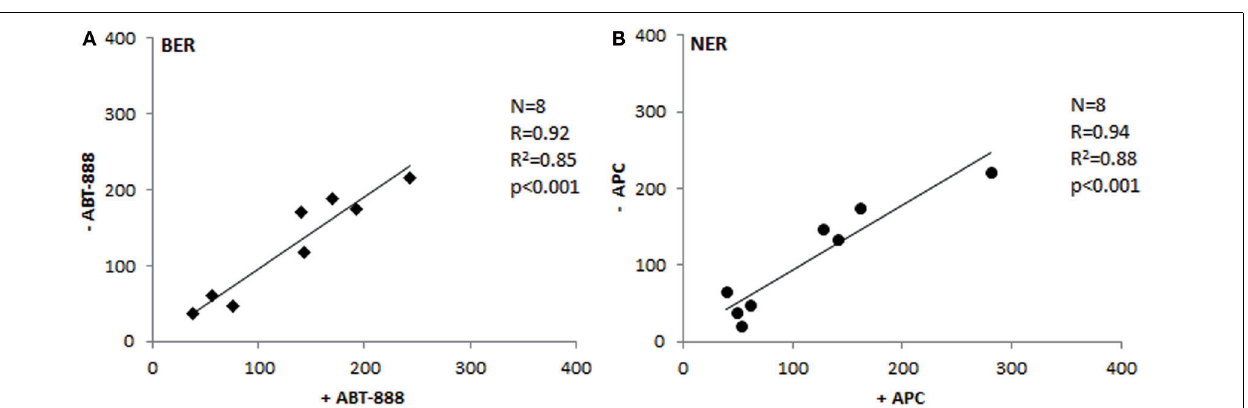
FIGURE 4 | Relationship between protein concentration of extract and its activity. Different protein concentrations of tissue extracts plotted against their BER (A) and NER (B) activities. Each experimental point represents mean ± SD of duplicate measurements.